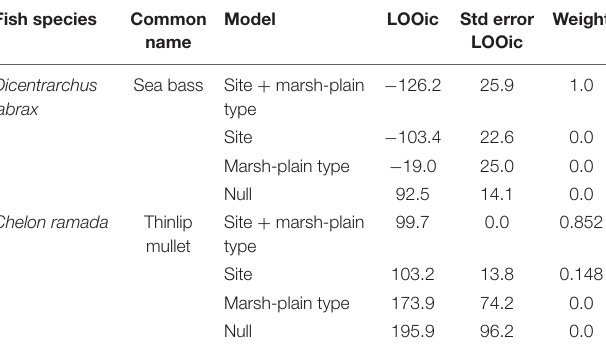
TABLE 2 | LOOic values of each mixing model tested with primary producers (microphytobenthos, particulate organic matter, and terrestrial vegetation). Fish species